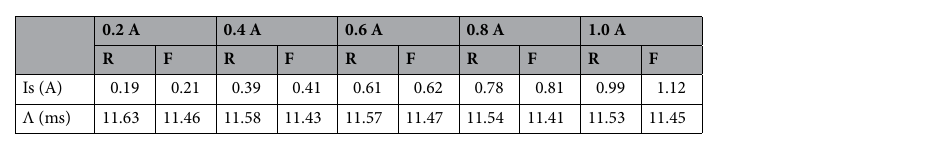
Table 2. Fitting parameters for the response characteristic according to Eqs. (2) and